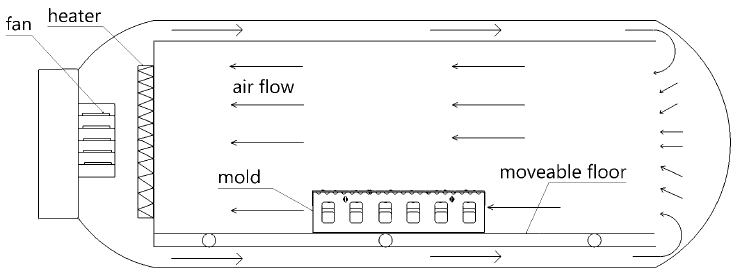
Figure 5. The working principle of autoclave.